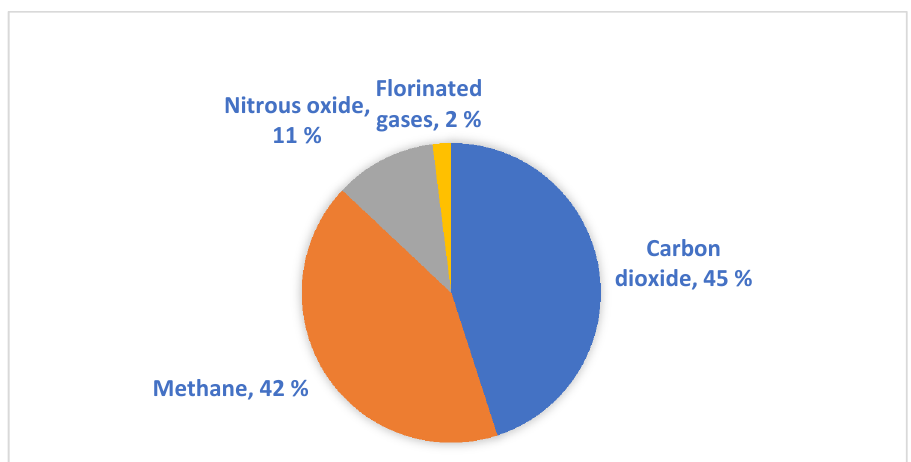
Figure 4. Percentage gas contribution to gross GHG emissions in 2017 (This work uses material sourced from the Ministry for the Environment, Stats NZ, and data providers, which is licensed by the Ministry for the Environment and Stats NZ for re-use under the Creative Commons Attribution 3.0 New Zealand licence [39]).